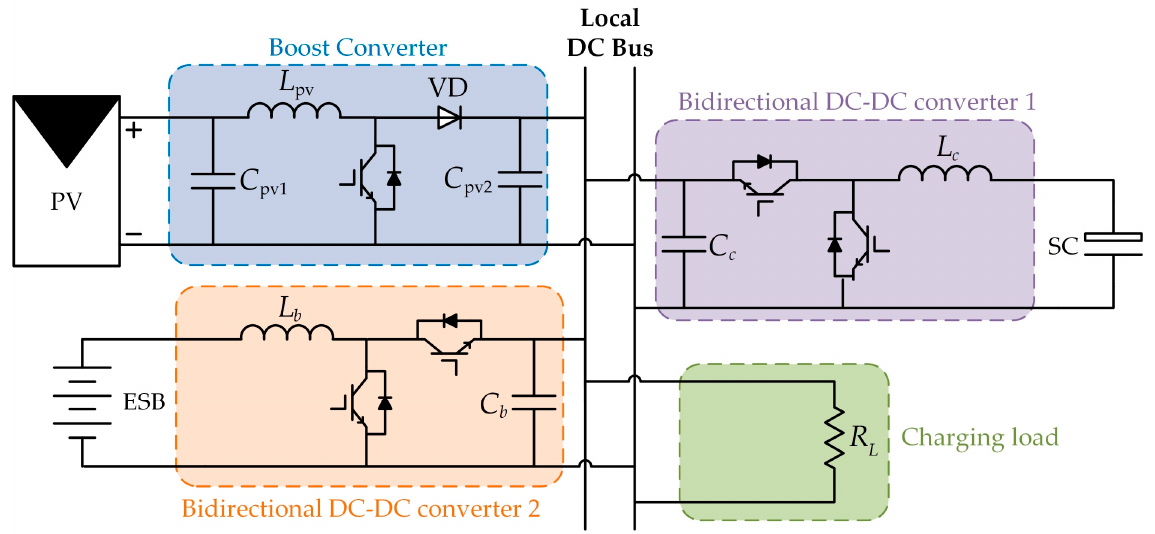
Figure 2. Single-group PV energy storage and charging system model with a boost converter and DC–DC converters.